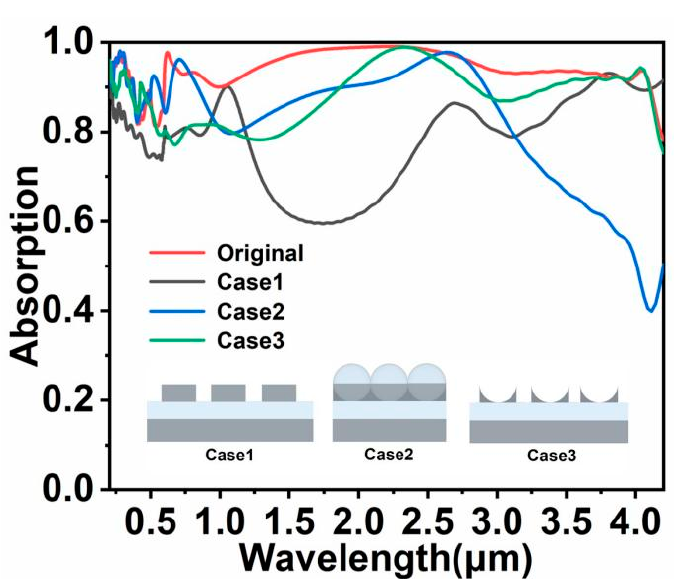
Figure 5. Absorption spectra of the original solar energy absorber, Case 1, Case 2, and Case 3, re- spectively.